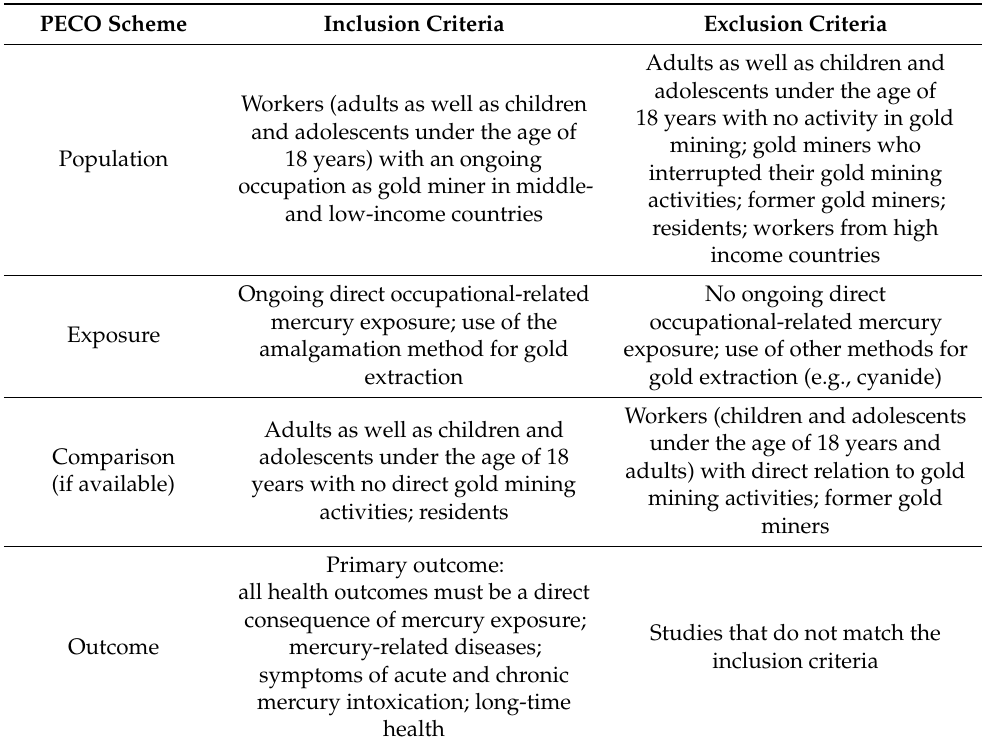
Table 1. Inclusion and Exclusion